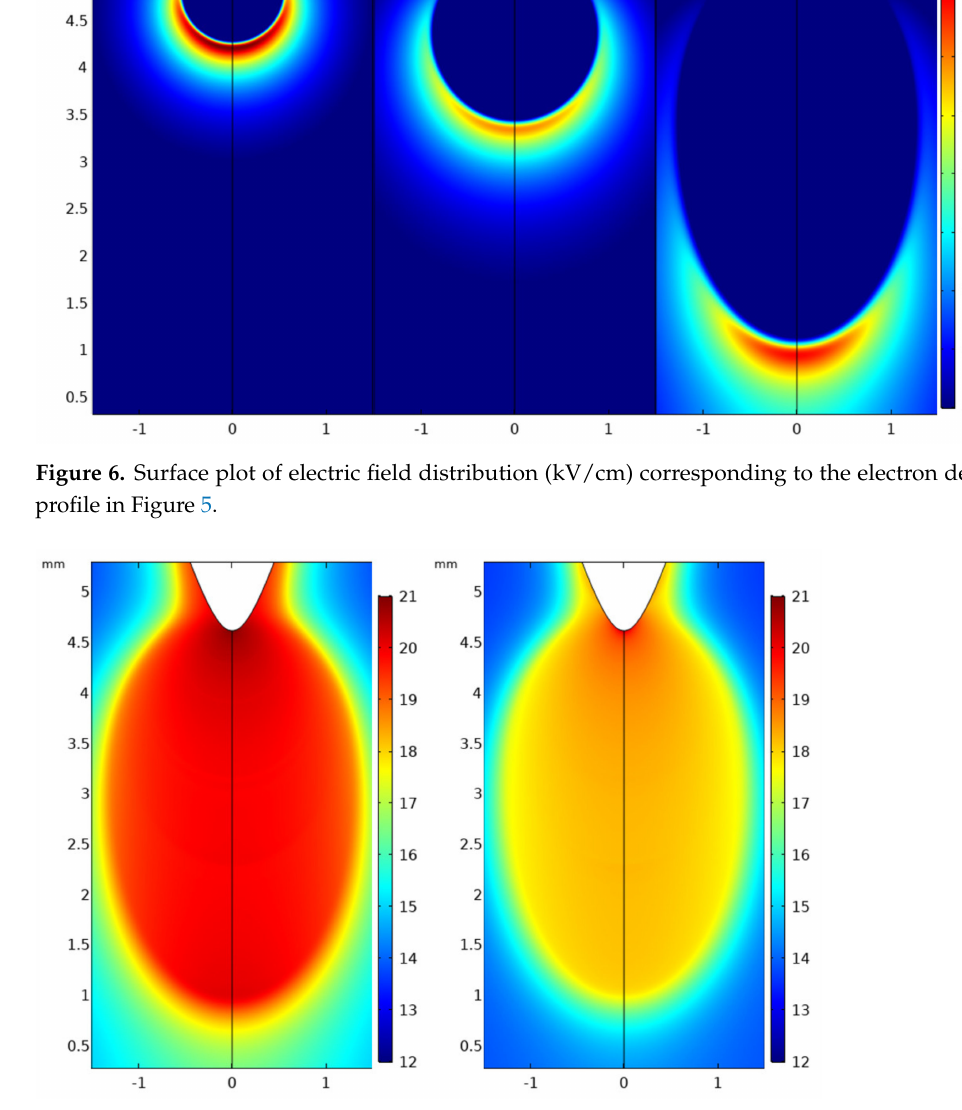
Figure 7. Surface plot of positive ion density profile ( left ) and negative ion density profile ( right ) at time 2 ns in air at atmospheric pressure. Scaling parameter: 20 on logarithmic plot represents a density value of 10 20 m − 3